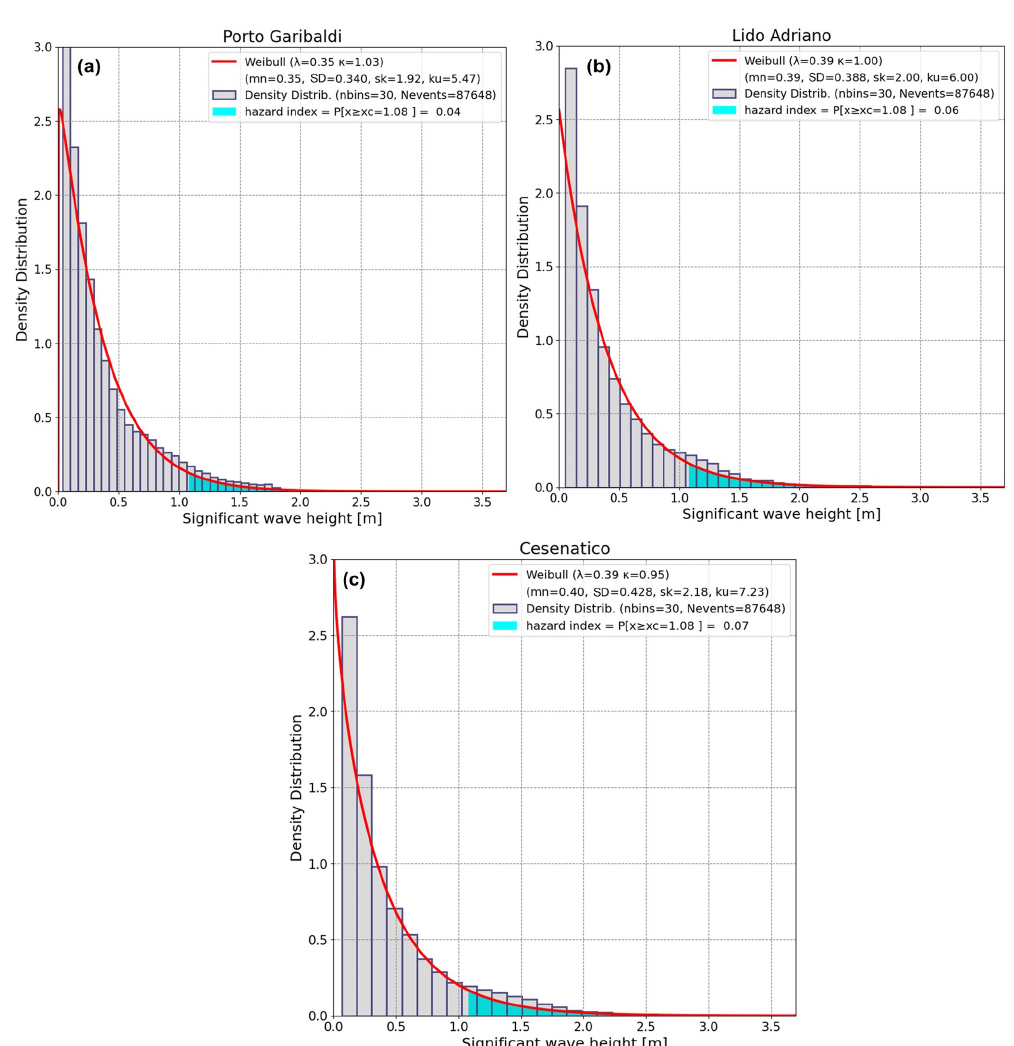
Figure 13. Comparison of the Weibull distribution fit (red line) to the histogram of the model data (2010–2019) for the control points: (a) Porto Garibaldi, (b) Lido Adriano, and (c) Cesenatico. The red line denotes the Weibull fit; the histograms represent the density distribu- tion (seen in grey colour), and the hazard index is indicated in cyan colour (mn: mean; SD: standard deviation; sk: skewness; ku: kurtosis; nbins: number of bins; Nevents: number of